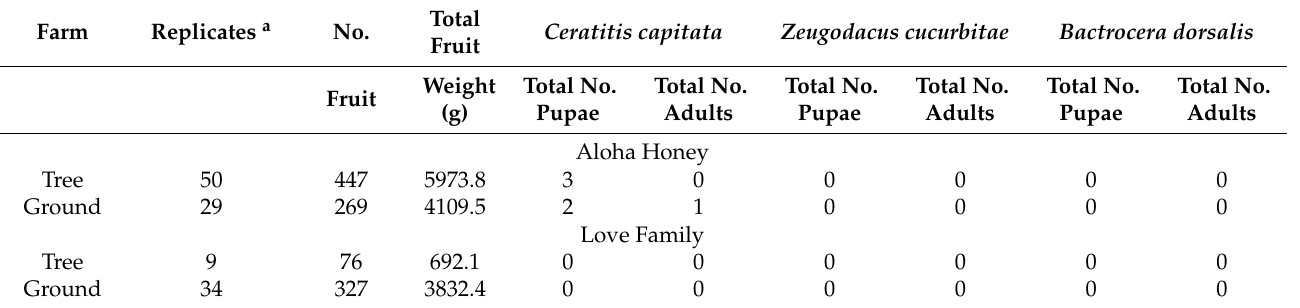
Table 4. Field infestation of finger lime fruit collected from off the tree and off the ground at two